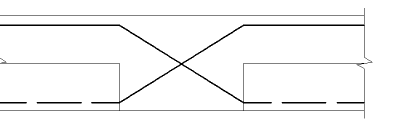
Figure 7. The keyway of the composite slab.